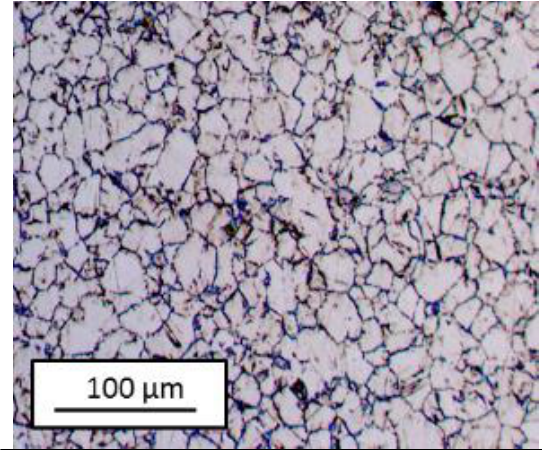
Figure 2: ASTM grain size near